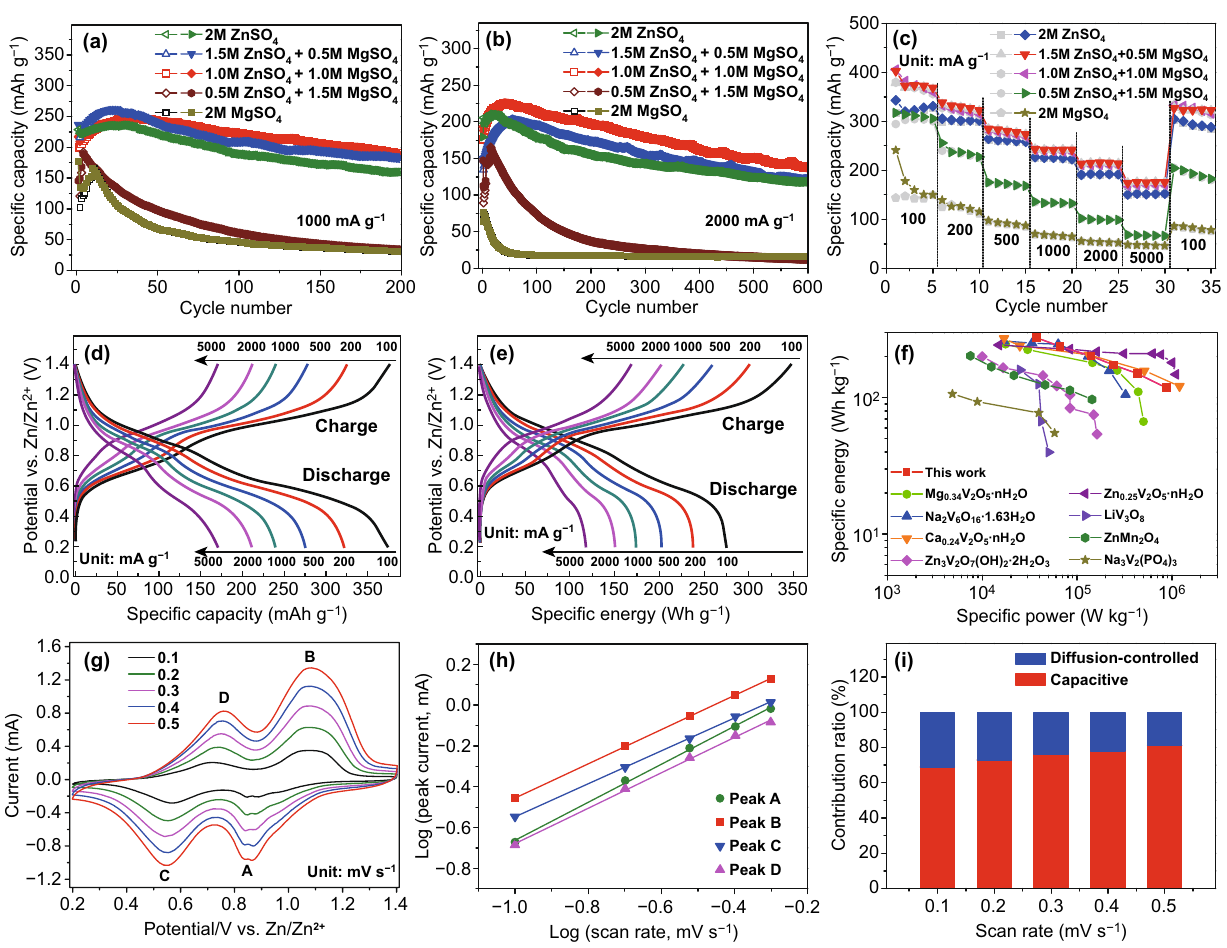
Fig. 4 Zn-ion storage performance of the as-obtained MgVO cathodes. Cycling performance at current density of a 1000 and b 2000 mA g −1 in different electrolytes. c Rate performance at various rates in five electrolytes. d Rate discharge–charge curves in 1.0 M ZnSO 4 –1.0 M MgSO 4 electrolyte and e the corresponding specific energies at each current density. f The Ragone plot of Zn//MgVO cell with 1.0 M ZnSO 4 –1.0 M MgSO 4 electrolyte, in comparison with other aqueous ZIBs: Mg 0.34 V 2 O 5 ·nH 2 O [13], Na 2 V 6 O 16 ·1.63H 2 O [12], Ca 0.24 V 2 O 5 ·nH 2 O [1], Zn 3 V 2 O 7 (OH) 2 ·2H 2 O [31], Zn 0.25 V 2 O 5 ·nH 2 O [11], LiV 3 O 8 [32], ZnMn 2 O 4 [10], Na 3 V 2 (PO 4 ) 3 [19]. g CV curves at different scan rates in 1.0 M ZnSO 4 –1.0 M MgSO 4 electrolyte and h the corresponding log(current) versus log(scan rate) plots of four peaks in the CV curves. i The capaci- tive contributions at different scan rates in 1.0 M ZnSO 4 –1.0 M MgSO 4